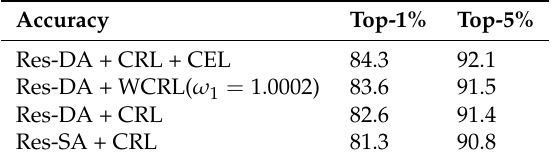
Table 10. Speaker identification results on the CN-Celeb dataset.